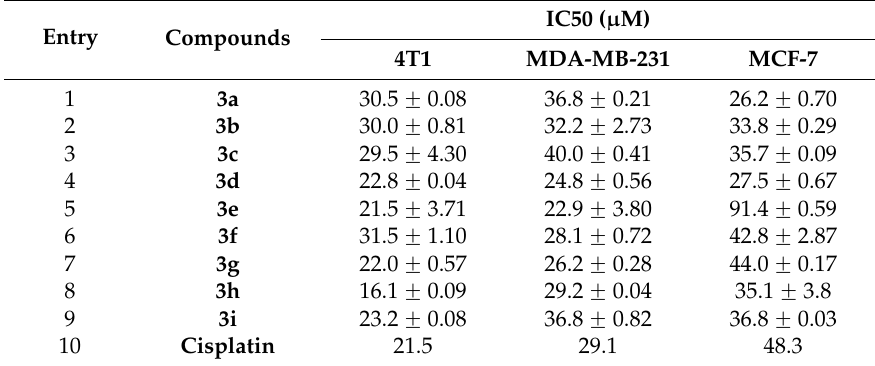
Table 1. Effect of 2,5-biaryl-3-hexylthiophene derivatives ( 3a – i ) on the growth of three human cancer cell